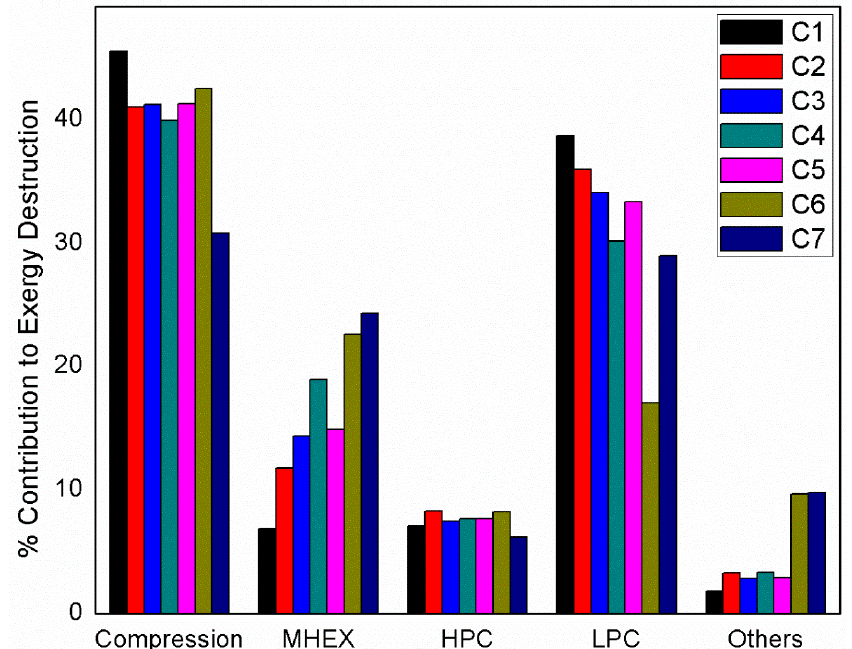
Figure 9. Contribution of different sections toward total exergy destruction in configurations